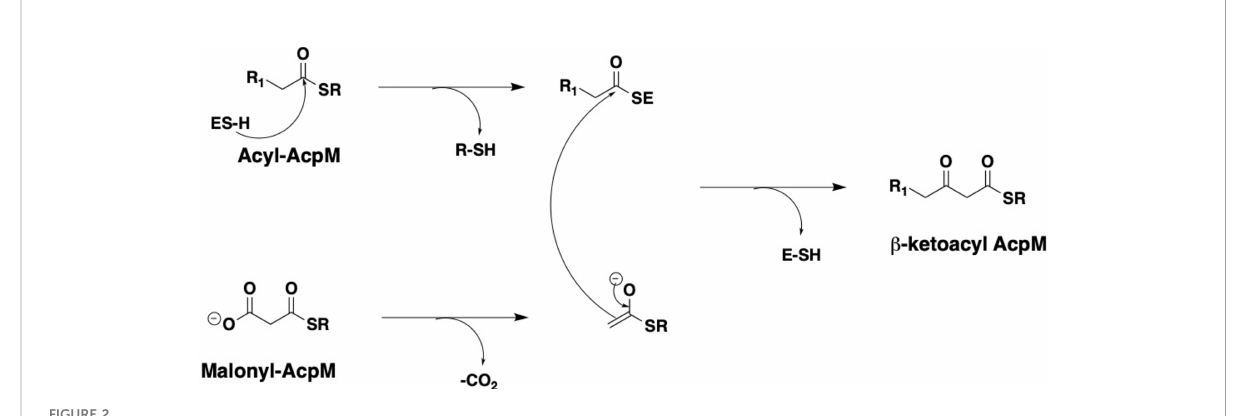
FIGURE 2 General catalytic mechanism of the KasA and KasB